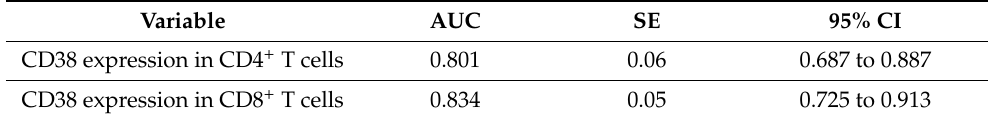
Table 8. ROC analysis of CD38/CD4 + cells and CD38/CD8 + cells to predict mortality among patients of the three studied groups.